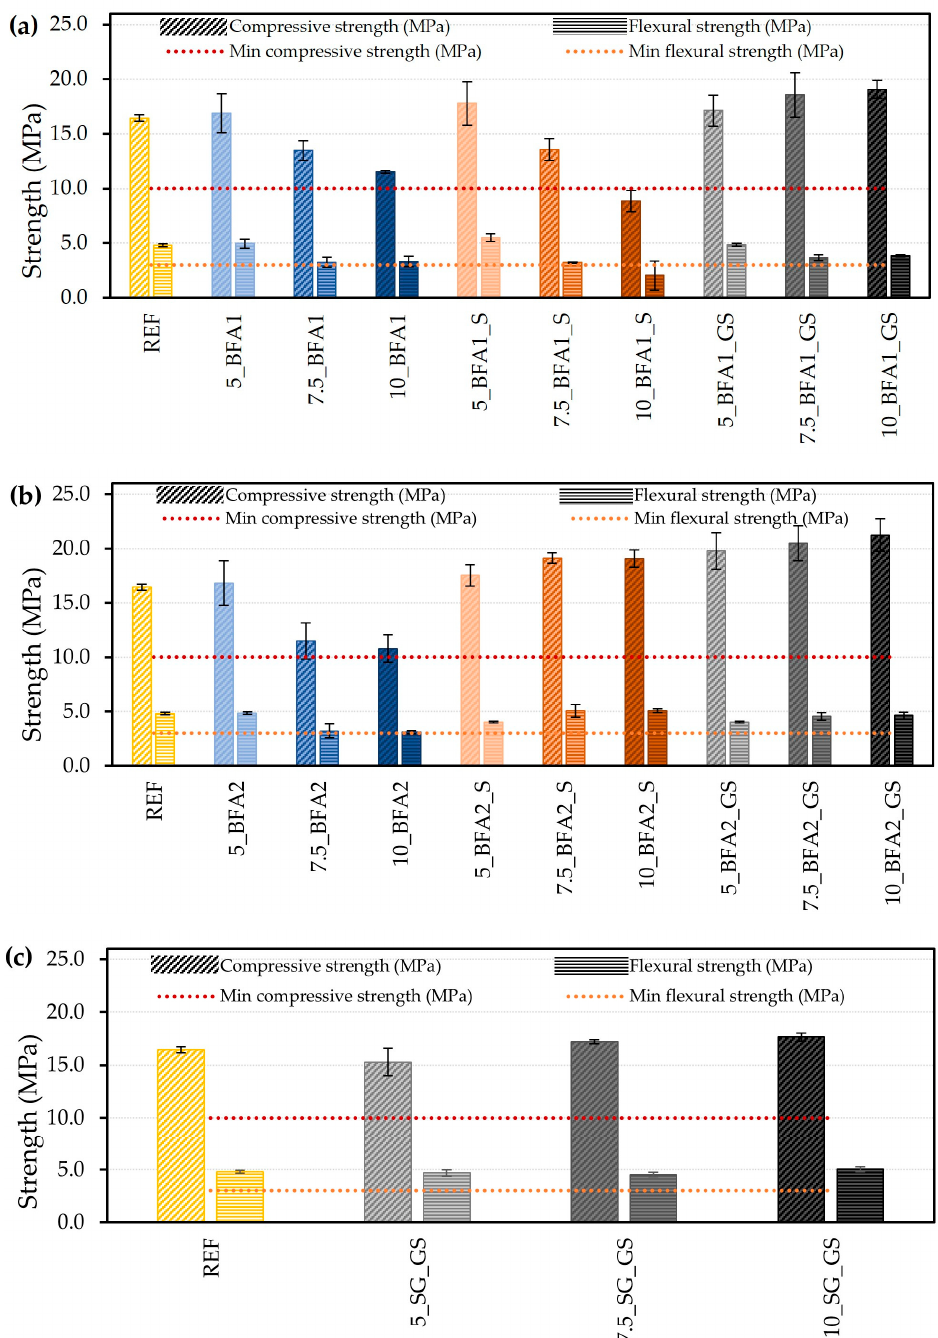
Figure 7. Flexural and compression strength. Samples prepared with: ( a ) BFA1, ( b ) BFA2, and ( c ) SG.